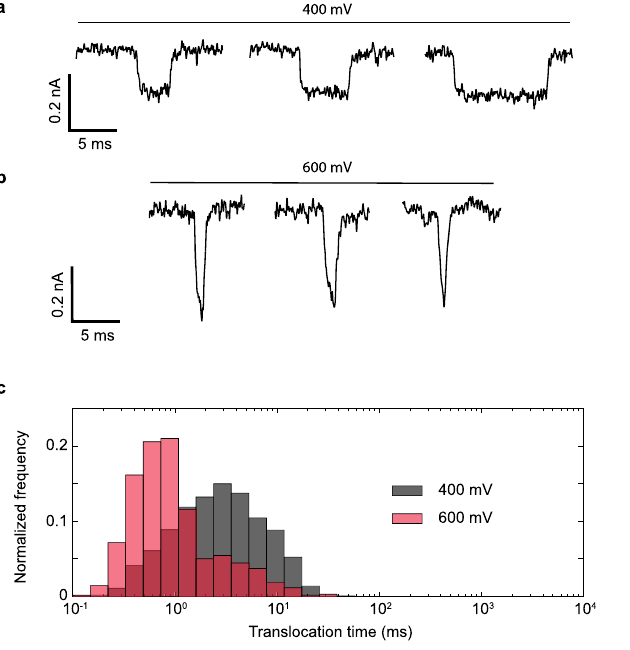
Fig. 5 Effects of electric fi eld leakage on dsDNA transport. a Representative translocation signals for 22 bp dsDNA translocations at applied voltages of 400 mV. b Representative translocation signals for 22 bp dsDNA translocations at applied voltages of 600 mV. c Normalized histogram of corresponding translocation times at applied voltages of 400 mV ( n = 701 events) and 600 mV ( n = 1762 events) and average translocation time as a function of applied voltage. Increasing the strength of electric fi eld leakage decreases the translocation time of dsDNA. Data were acquired using a nanopore coated with 3 nm Al 2 O 3 fi lm (diameter, 8 nm; half cone angle, 9 ±